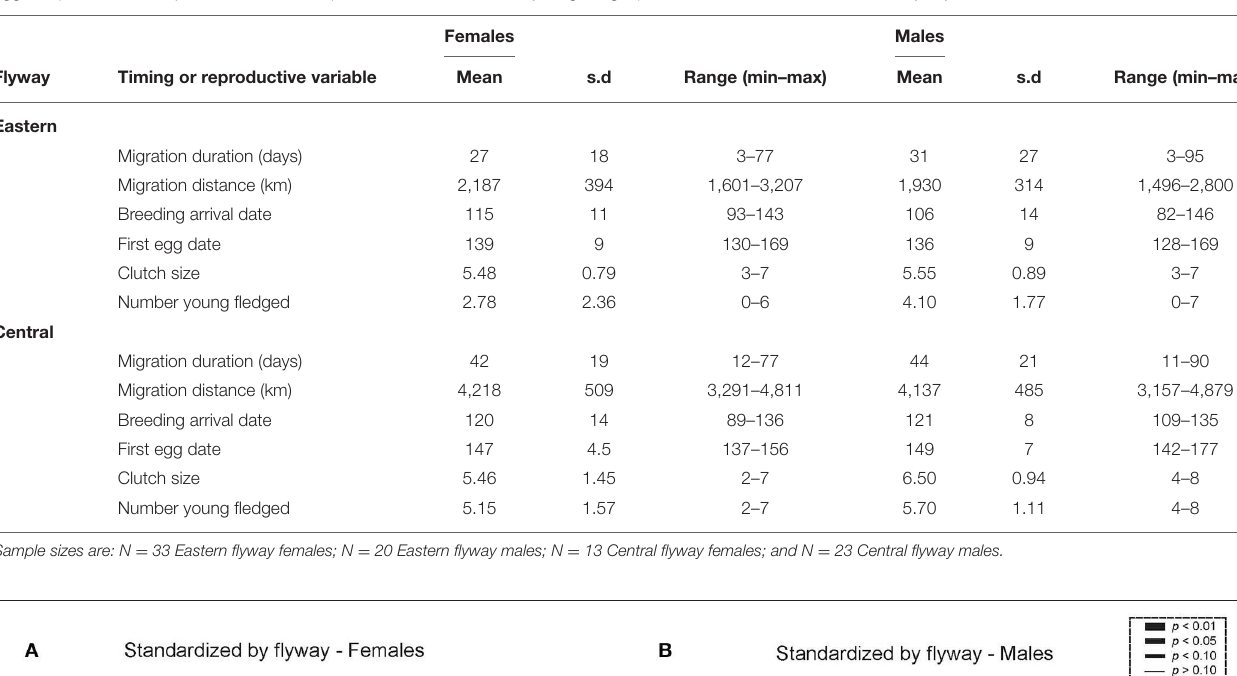
TABLE 2 | Summary of the means, standard deviations (s.d.) and range (minimum and maximum) of migration distance and duration, timing (breeding arrival date, first egg date) events, and reproductive variables (clutch size and number of young fledged) for females and males within each flyway.